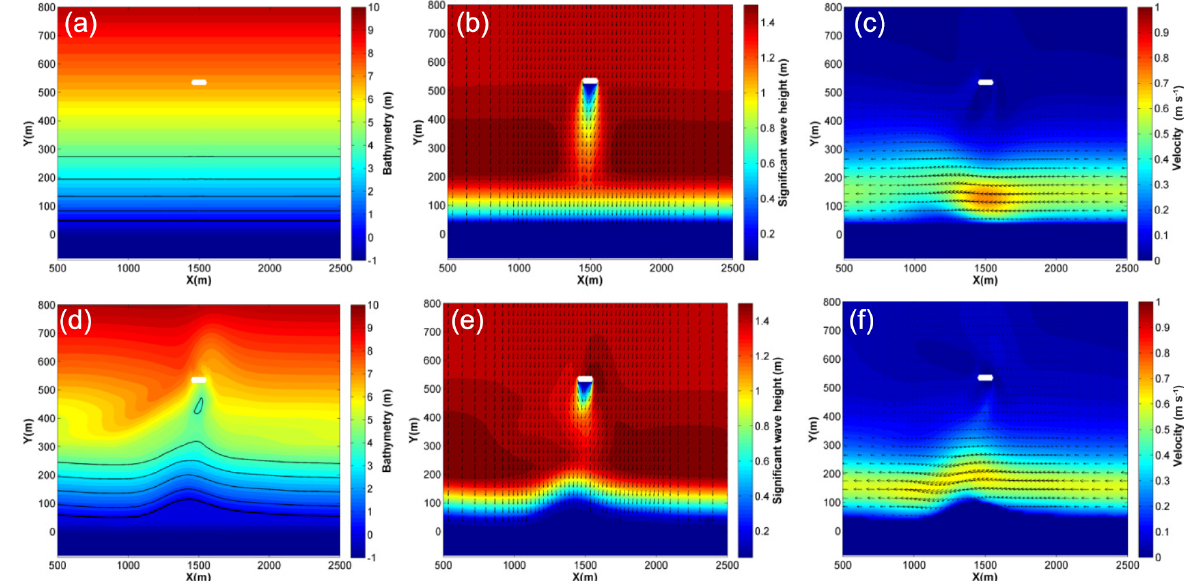
Figure 2. Model results for the breakwater’s length-to-distance ratio of 0.2. Bathymetry (a, d) , waves (b, e) , and currents (c, f) for the initial condition (a, b, c) and near equilibrium (d, e, f) after 9 years. The thicker isoline in the bathymetry represents the shoreline, whereas the remaining ones represent the 1, 2, 3, and 4m isobaths.